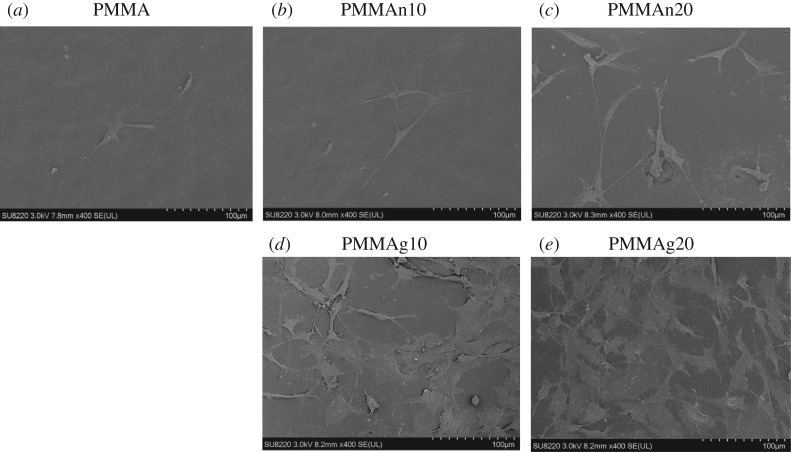
SEM images of cells seeded on tablets PMMA (a), PMMAn10 (b), PMMAn20 (c), PMMAg10 (d) and PMMAg20 (e) surfaces and then incubate for 3 days.